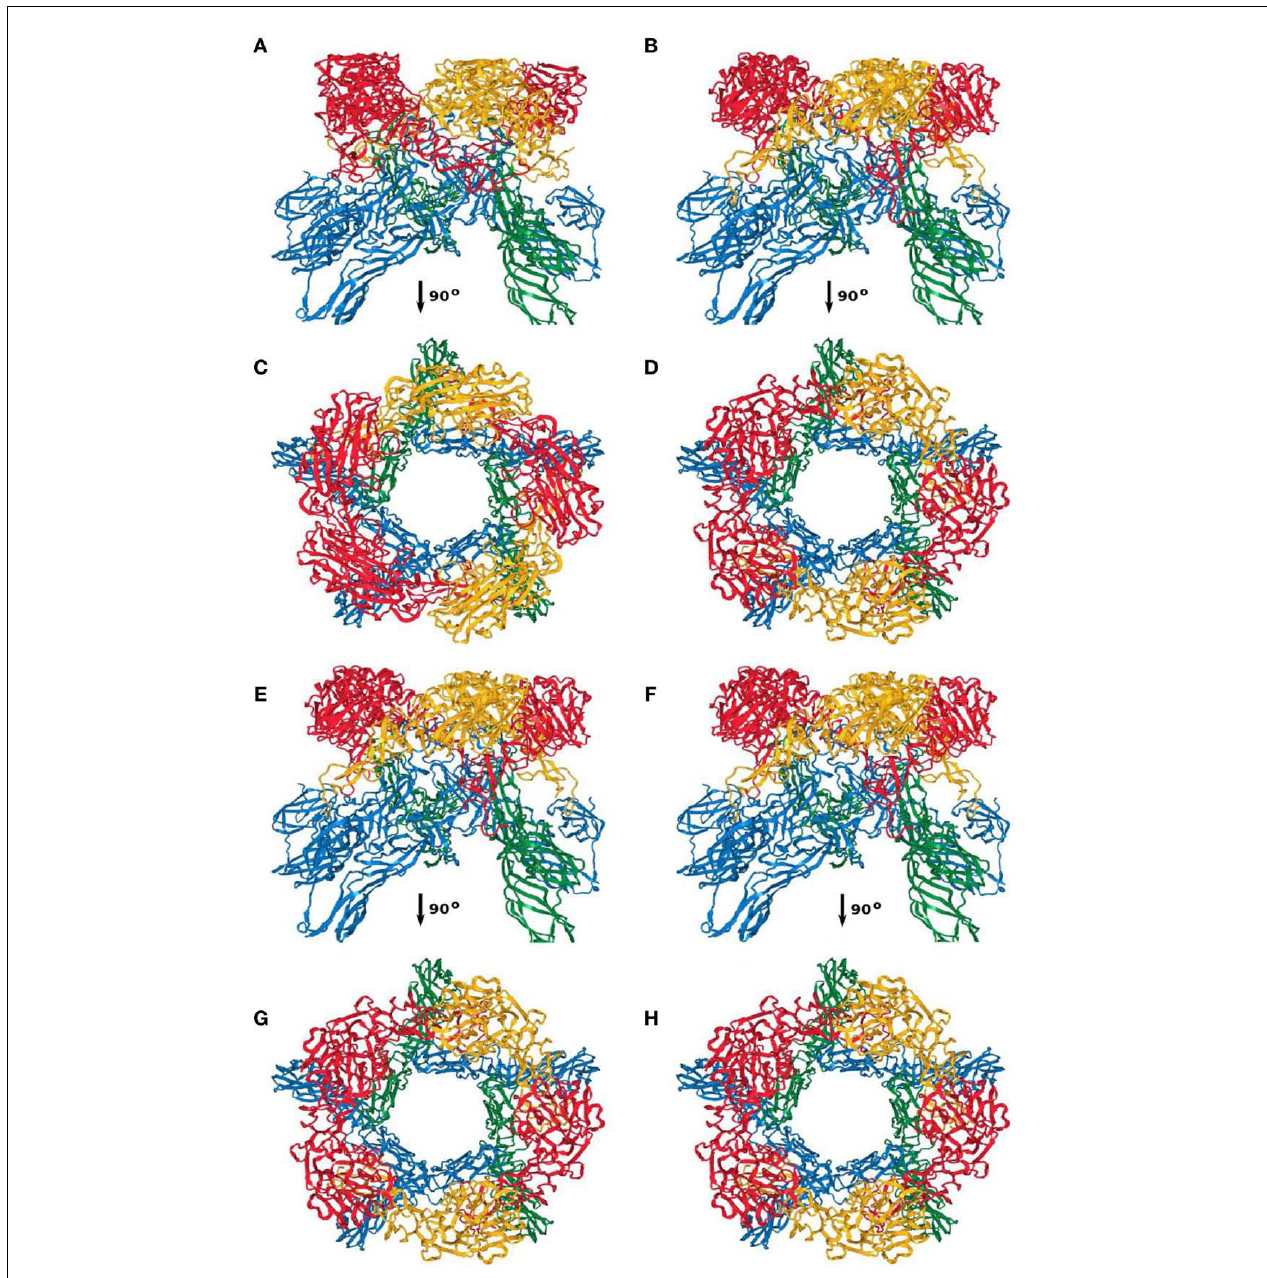
FIGUREA4 | Capsomer fivefold axis; (A,C) first; (B,D) second; (E,G) third; (F,H) fourth top-scoring model.